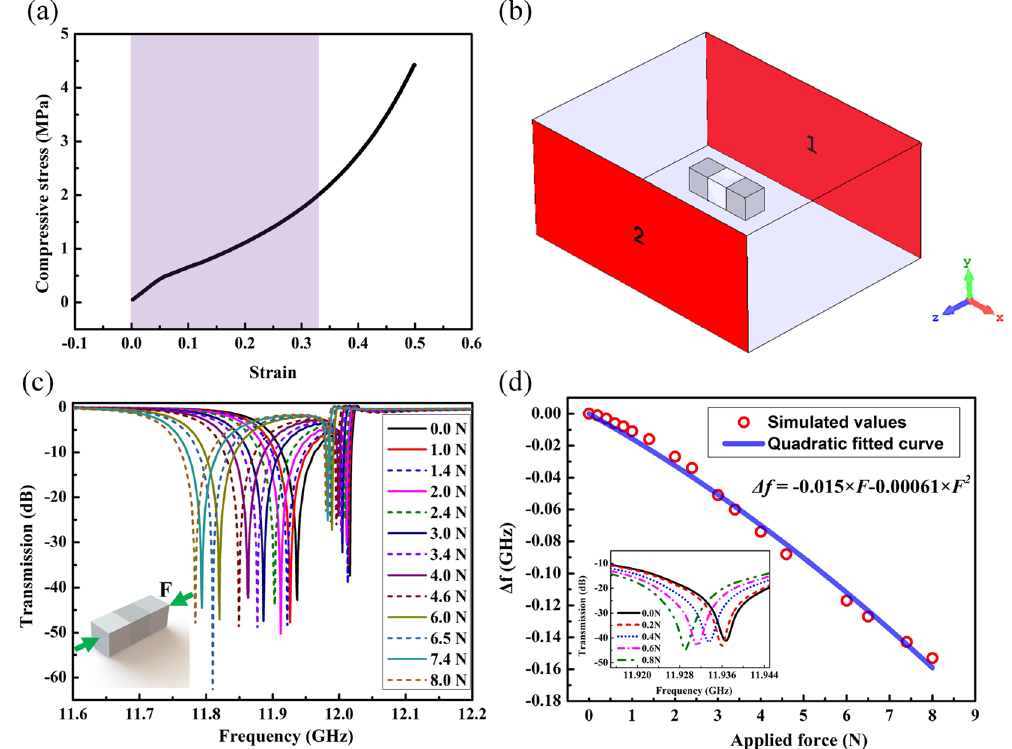
Figure 1. ( a ) The measured relationship between the compressive stress and strain for the silicone rubber. ( b ) The simulation setup in the CST microwave studio. ( c ) The simulated transmission spectra curves of the dielectric Mie resonant antenna under different compressive force levels. ( d ) The calculated relationship between the frequency shift and the applied force. The inset of ( d ) shows the simulated frequency shift at five loading levels from 0 N to 1